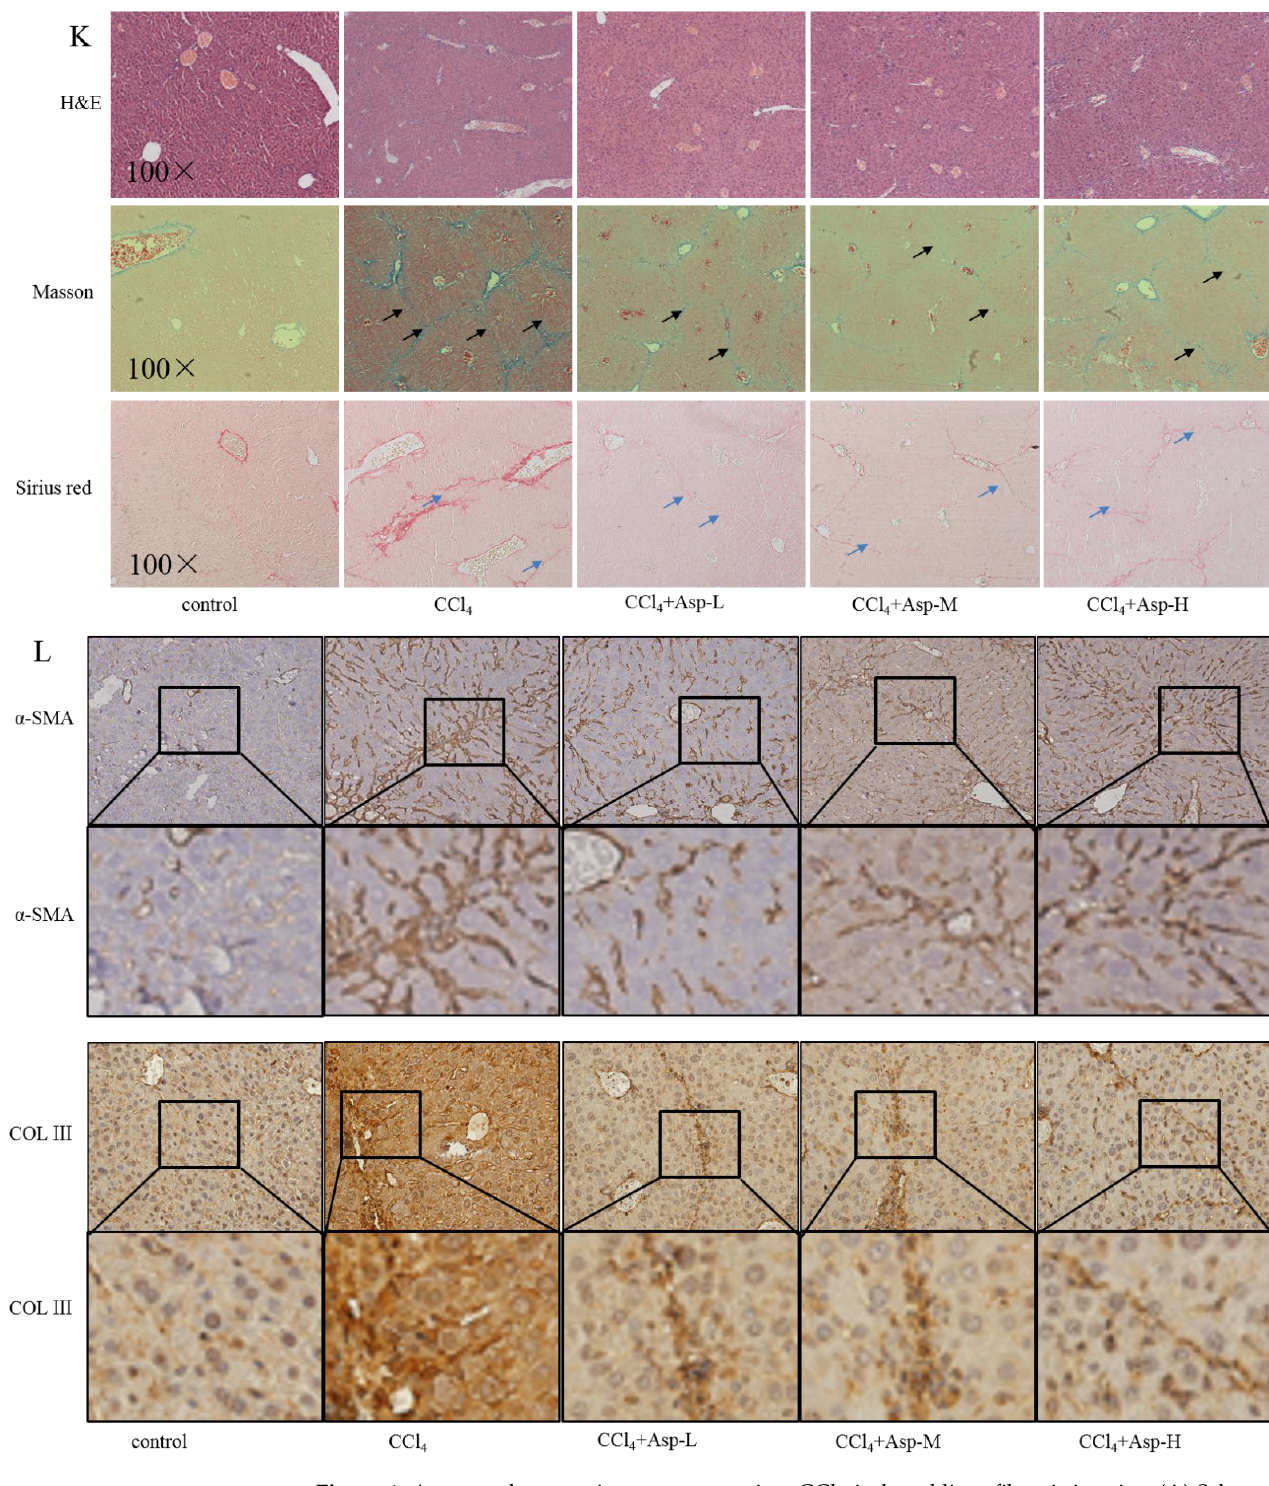
Figure 1. Asp supplementation protects against CCl 4 -induced liver fibrosis in mice. ( A ) Schematic illustration of animal models in mice. ( B , F ) The activities ALT and AST were assayed by using a semi-automated blood chemistry analyzer. ( G ) The serological levels of HA, LN, COL Ⅲ and COL IV were detected. ( C , H ) The expression of the myofibroblast marker α -SMA and collagen was detected by real-time PCR. ( D , I ) Protein levels in liver tissues were analyzed by Western blot analysis, ( J ) which were quantified using the ImageJ software. ( E , K ) Liver tissues were harvested 48 h after the final CCl 4 injection and stained with hematoxylin–eosin, Masson Black arrow (Black arrow), and Sirius Red (Blue arrow) (×100). ( L ) Liver fibrosis was observed by immunohistochemical staining of α -SMA/COL Ⅲ -positive cells. ( M , N ) The Sirius red and Masson-stained area in treated and non- treated animal have been quantified using the Image J software. Data represent the mean ± SD from 6 to 8 separate experiments (significant as compared with vehicle-treated control, * p < 0.05, ** p < 0.01; *** p < 0.001 by ANOVA).